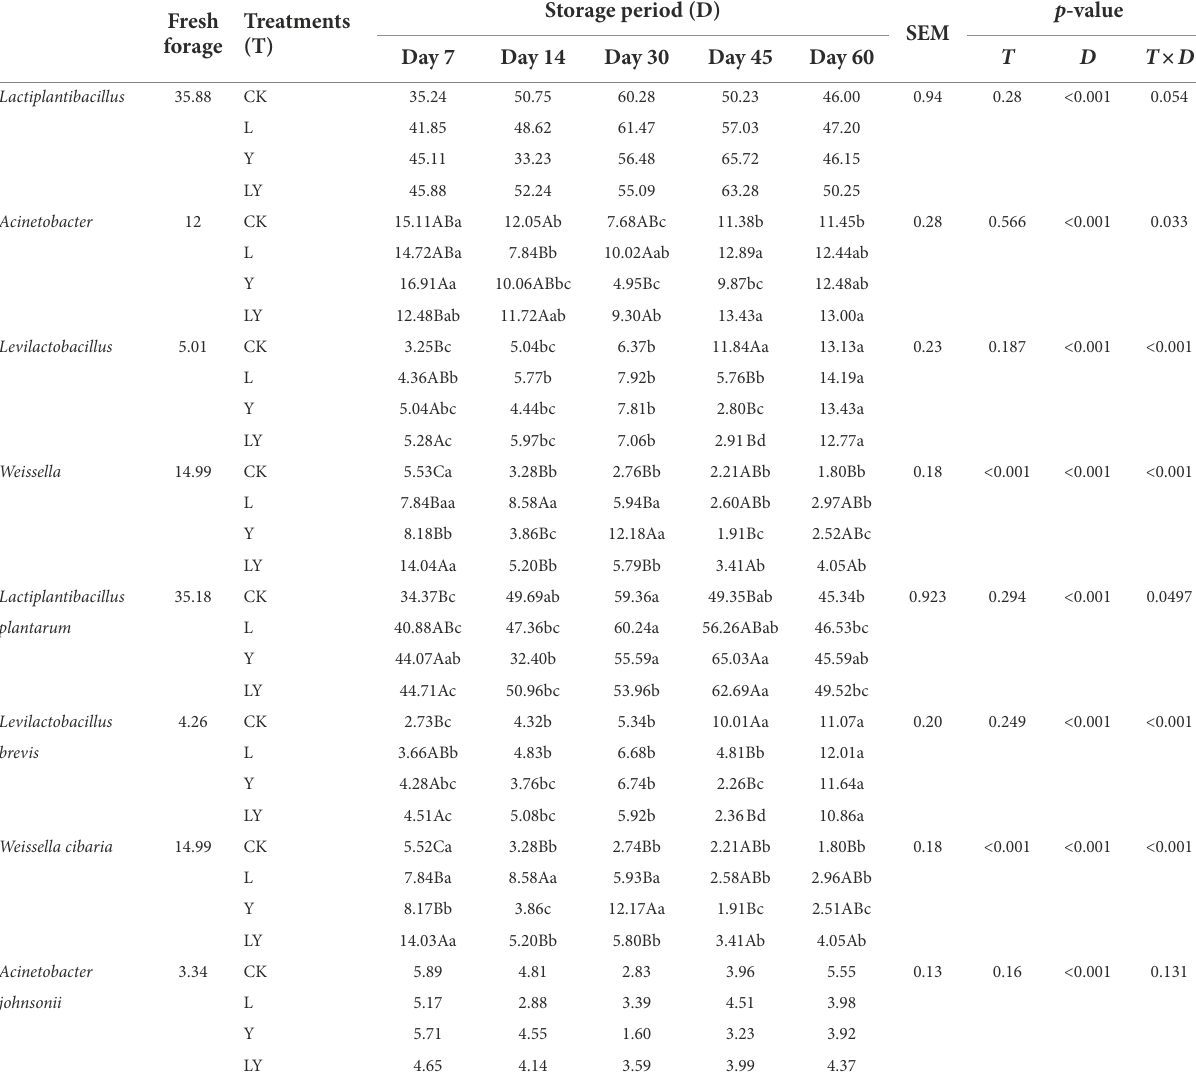
TABLE 5 Relative abundance (%) of top four bacteria at different taxonomic levels in cellulase-treated Pennisetum sinese (CTPS) before and after anaerobic storage. Fresh Treatments forage